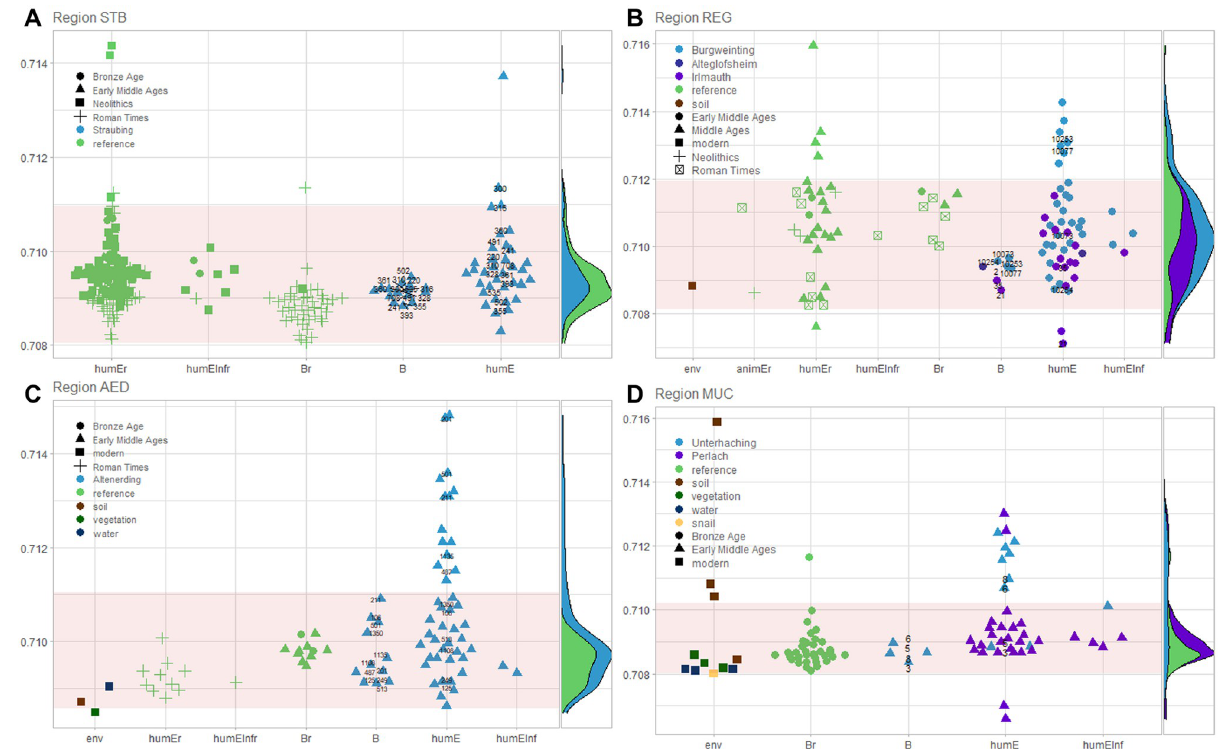
Fig 3. Local ranges and distribution of 87 Sr/ 86 Sr values per region and site. (A) Region Straubing (STB), (B) Region Regensburg (REG), (C) Region Erding (AED) and (D) Region Munich (MUC). 87 Sr/ 86 Sr (y-axis) of samples from predefined study region divided into groups (x-axis): env = environmental samples, animE = animal enamel, humE = human enamel, humEInf = human enamel of infans (0–12 years), B = bone (animal or human) (followed by an r = part of the reference data set, no r = archaeological site investigated). Red area: calculated range of bioavailable strontium based on all biomineral samples of the region. Symbols provide a chronological classification. Numbers = grave numbers of individuals from which both bone and enamel were measured. If values from environmental samples were known from the literature, they were added for comparative reasons: Lengfelder et al. [112]: soil, vegetation, water for AED and MUC, Hoogewerff et al. [113]: soil for REG, Neumann et al. [114]: soil and snail MUC. Right side: Distribution of samples separated by reference and respective site: Straubing (STB): N = 217, Regensburg (REG): N = 80, Erding (AED): N = 78, and Munich (MUC): N = 76 (illustration: R with packages ggplot2 [115, 116], ggbeeswarm [117], ggside [118], ggrepel